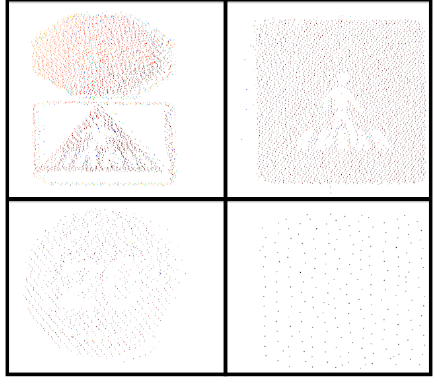
Figure 3. Histogram of intensity values for a point cloud containing sign panels, poles and floor points in a neighbourhood of each signal.